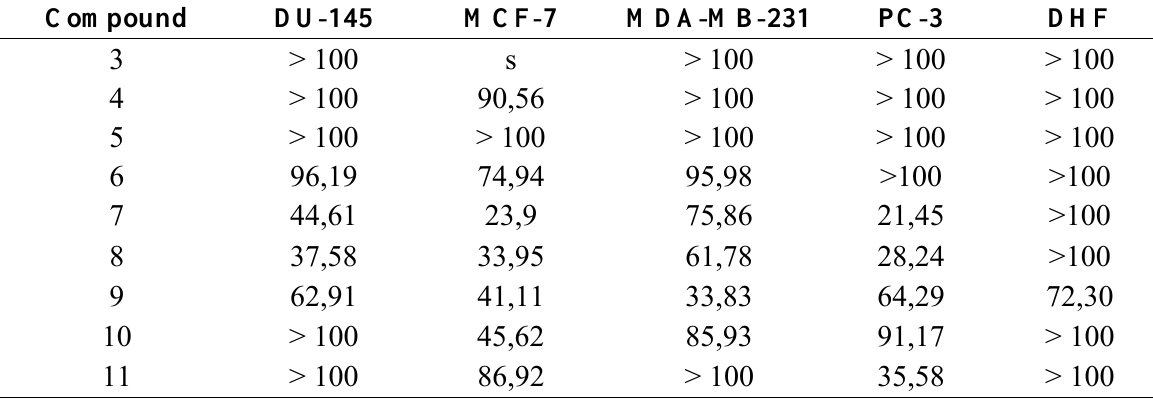
µM) of natural ent -labdane derivatives 3 - 50